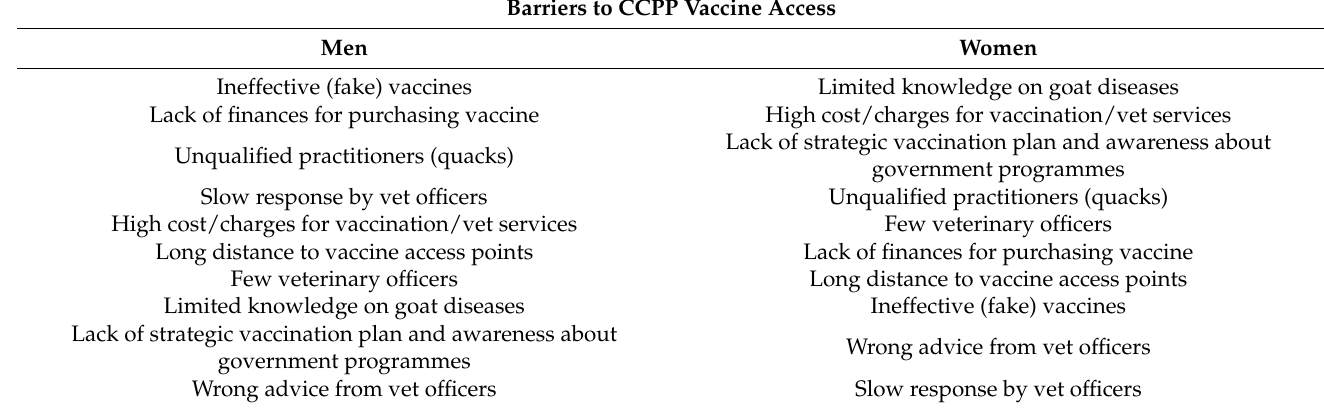
Table 2. Identified barriers for men and women smallholder farmers to access CCPP vaccines listed in order of